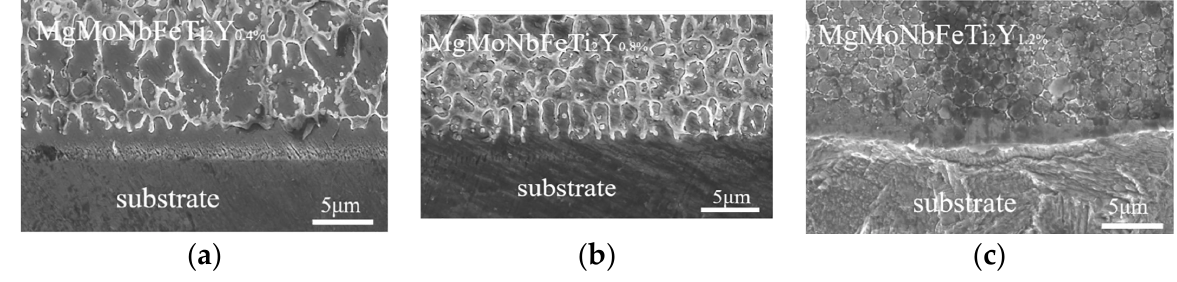
Figure 14. SEM micrographs of MgMoNbFeTi 2 Y x HEAs with x = 0.4% ( a ), x = 0.8% ( b ), and x = 1.2% ( c ). Reprinted with permission from Ref. [78]. Copyright 2020 Elsevier.